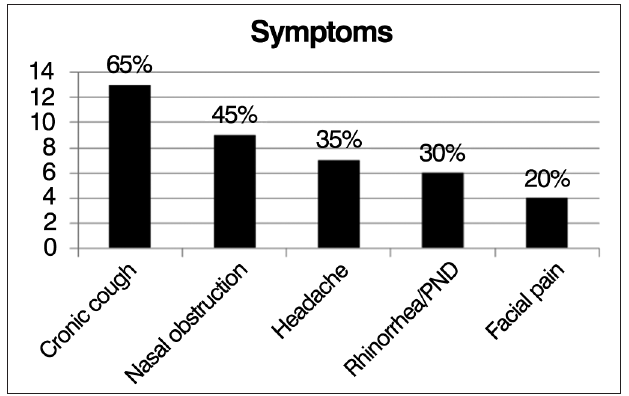
Figure 2. Distribution of frequencies of respiratory symptoms.